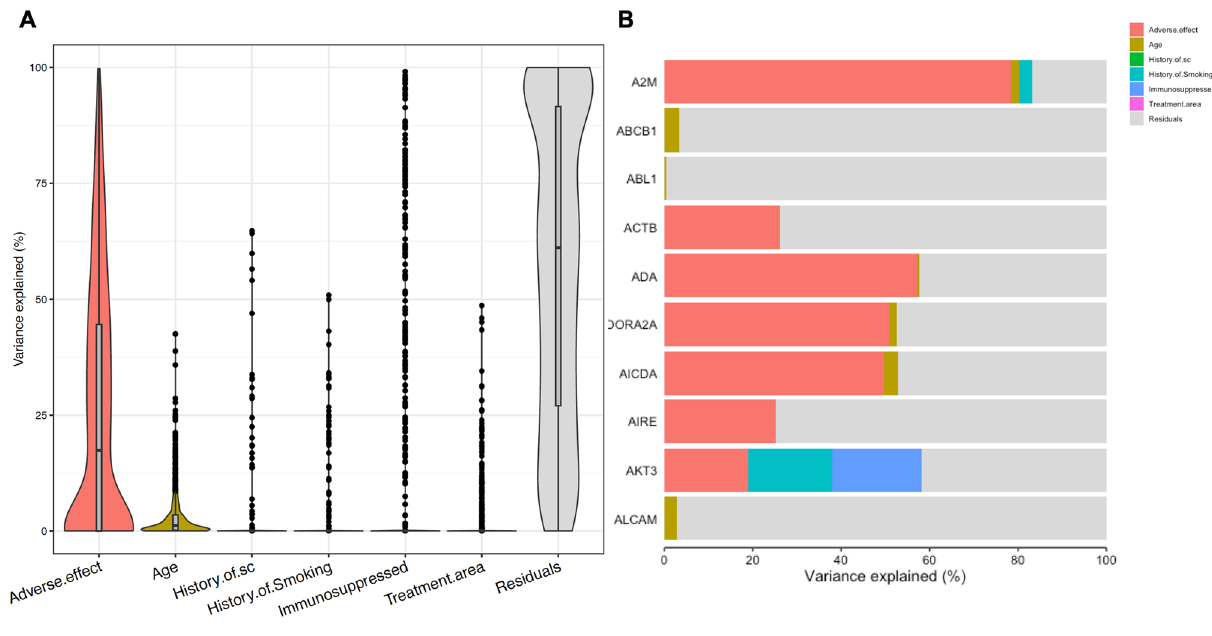
Figure 4. ( A ) Violin plot examining the effects of potential confounders on clinical outcomes. ( B ) Variance explained by gene for the first ten genes in the